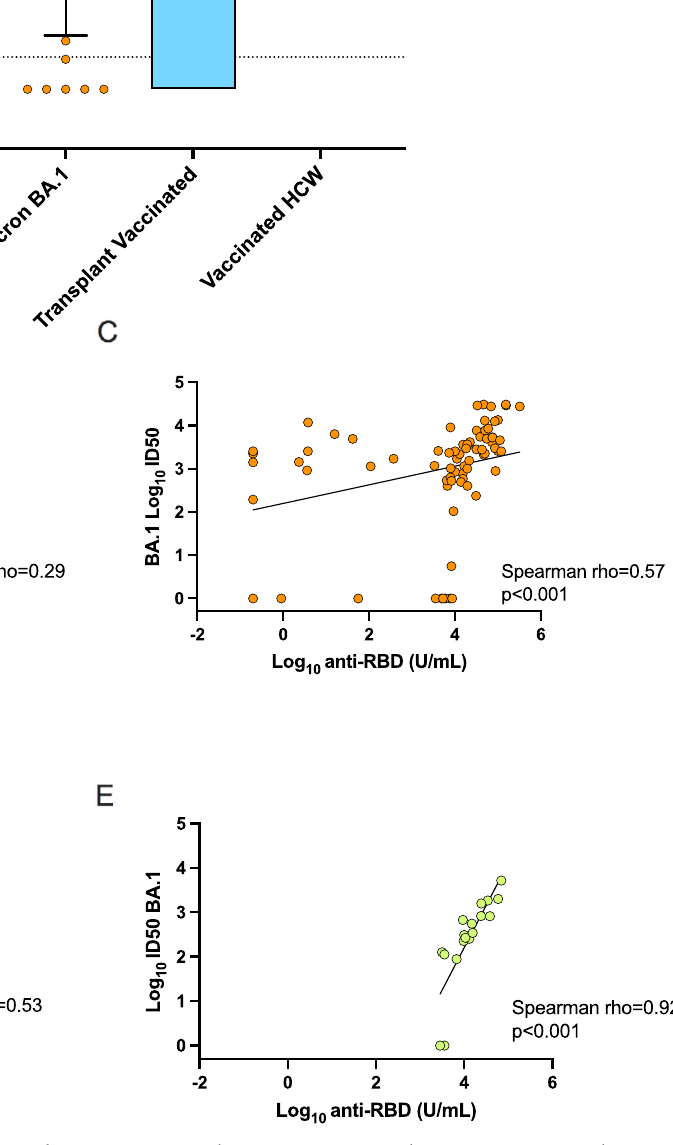
comparison: Cohort 1 vs. 2 p <0.001, Cohort 1 vs. 3 p <0.001, Cohort 2 vs. 4 p =0.76. B – E Scatter plots showing two-tailed Spearman correlation between the log 10 ID50ofneutralizingantibodytitersagainstOmicronBA.1(y-axis)andthelog 10 anti-RBDlevelinU/mL(x-axis)ineachcohort:( B )infectednon-Omicron, p =0.005; ( C ) infected BA.1, p <0.001; ( D ) three-dose vaccinated transplant patients unin- fected, p <0.001; and E three-dose vaccinated healthcare workers, p <0.001. Diagonallinesrepresentthebest- fi tlinearregressionline.Sourcedataareprovided as a Source Data fi